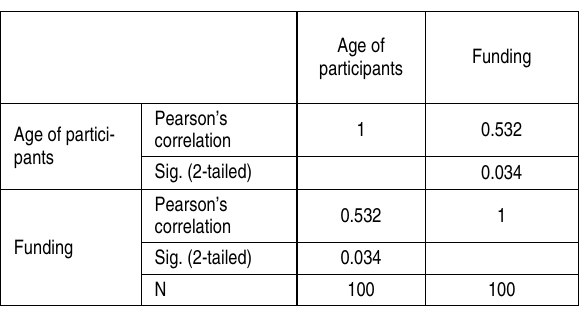
Table 2. Age versus funding